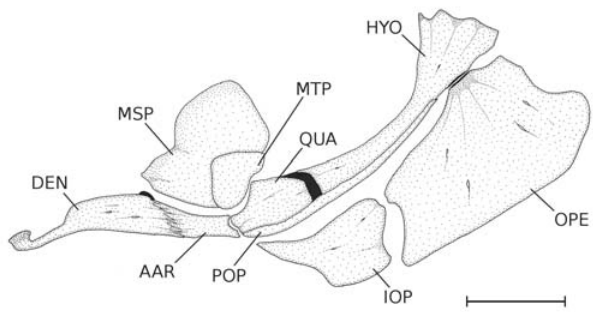
Fig. 8. Suspensorial and opercle series in Leptodoras oyakawai , based on MZUSP 95722, 73 mm SL, in lateral view. AAR anguloarticular, DEN dentary, HYO hyomandibula, IOP interopercle, MSP mesopterygoid, MTP metapterygoid, OPE opercle, POP preopercle, QUA quadrate. Scale bar 5 mm.